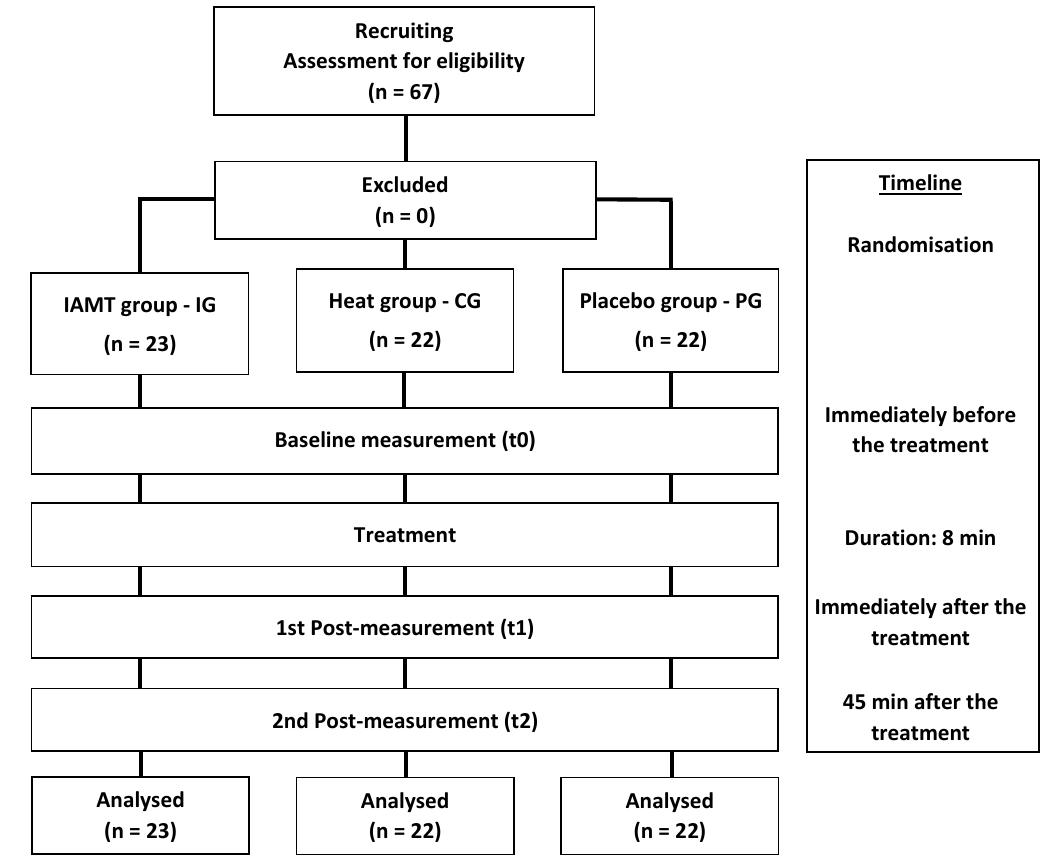
Figure 1. Schematic representation of the study design. IAMT: instrument ‐ assisted manual therapy; IG: intervention group; CG: comparison group; PG: placebo group. Adapted from the original by Weber et al. (2020) [37].